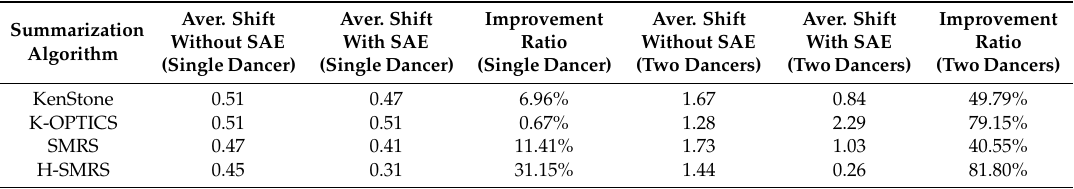
Table 4. The improvement ratio among the adopted summarization algorithms with and without the SAE framework for Syrtos (3b) dance sequence. Two different performances of the dance are assumed; one for a single dancer and one for two